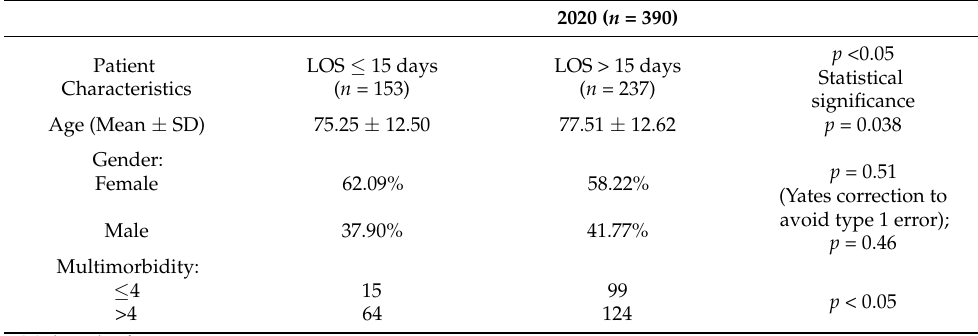
Table 1. Strata qualitatively assessed using Mann–Whitney and Chi-square (gender) respectively for patients admitted to the complex discharge